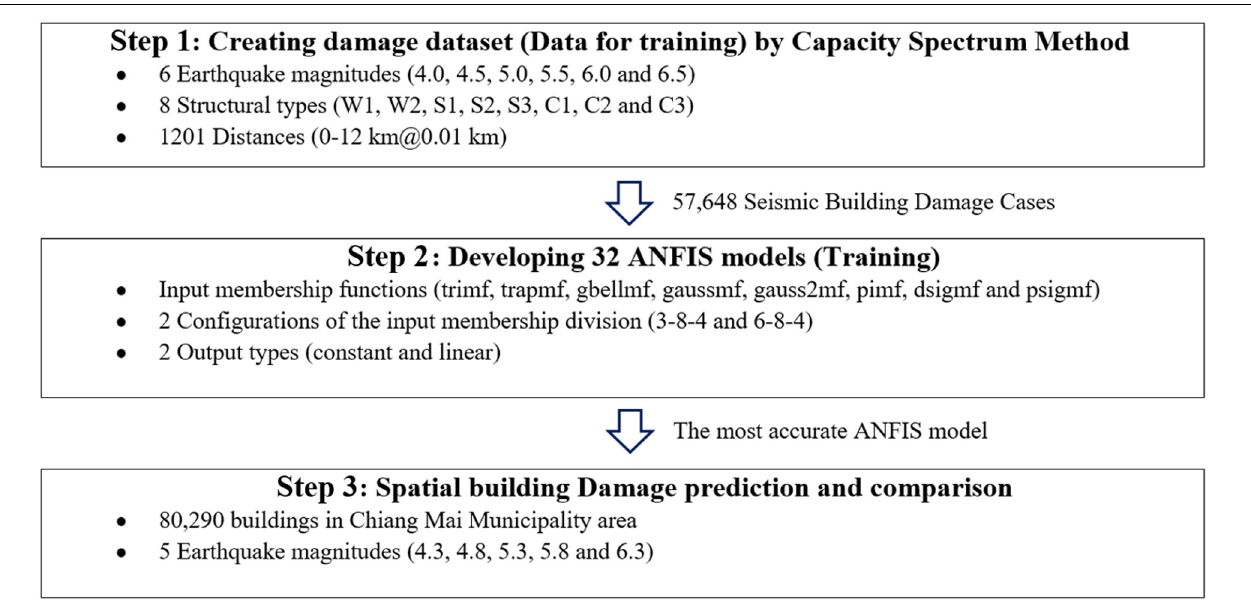
FIGURE 1 | Overview of the